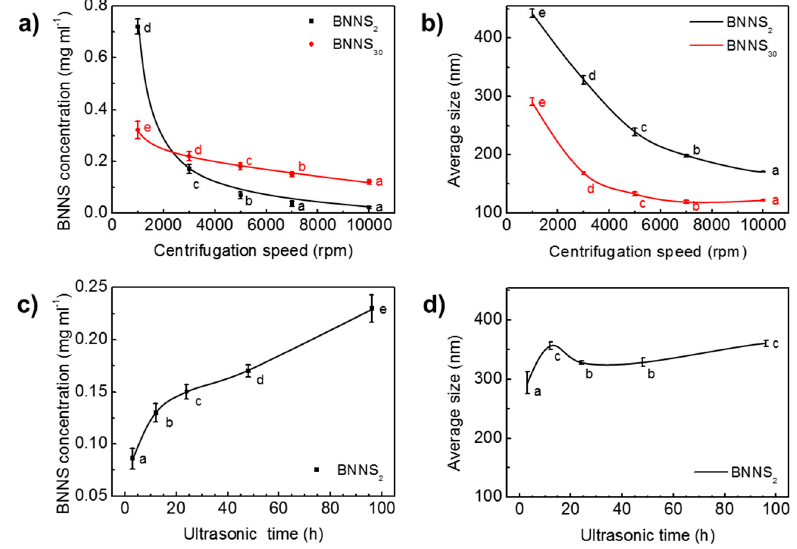
Figure 3. E ff ect of centrifugation speed on ( a ) BNNS concentration and ( b ) average size. E ff ect of ultrasonic time on ( c ) BNNS concentration and ( d ) average size. Data presented as means ± SD. α = 0.01, from small to large: a →